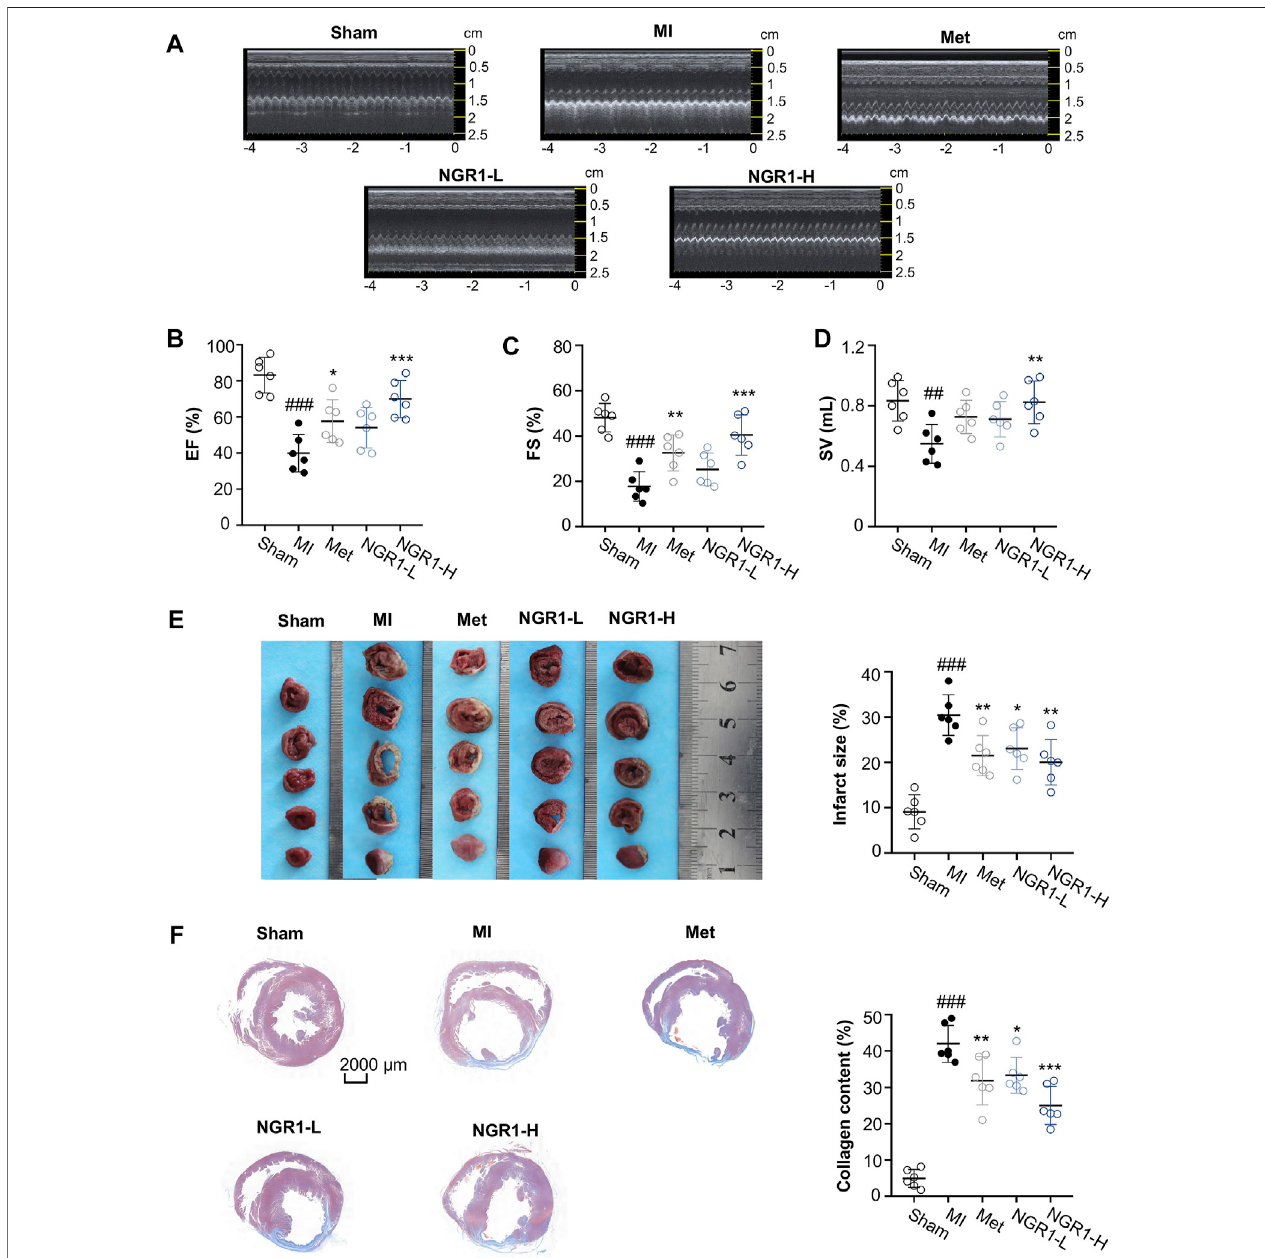
FIGURE 1 | NGR1 alleviates LADCA ligation – induced ventricular dysfunctions, myocardial infarction, and fi brosis. (A) Representative electrocardiogram and (B) values of EF (left ventricular ejection fraction), (C) values of FS (left ventricular fraction shortening), and (D) values of SV (stroke volume). (E) Representative photos of rat heart slices by TTC staining and quantitative analysis of infarct size. (F) Representative images of rat heart slices by Masson ’ s staining and quantitative analysis of collagen content. Scale bar = 2000 μ m. Values expressed as the mean ± SD. * p < 0.05, ** p < 0.01, and *** p < 0.001 vs. the MI group; # p < 0.05, ## p < 0.01, and #### p < 0.001 vs. the sham group ( n = 6 for sham, MI, Met, NGR1-L, and NGR1-H